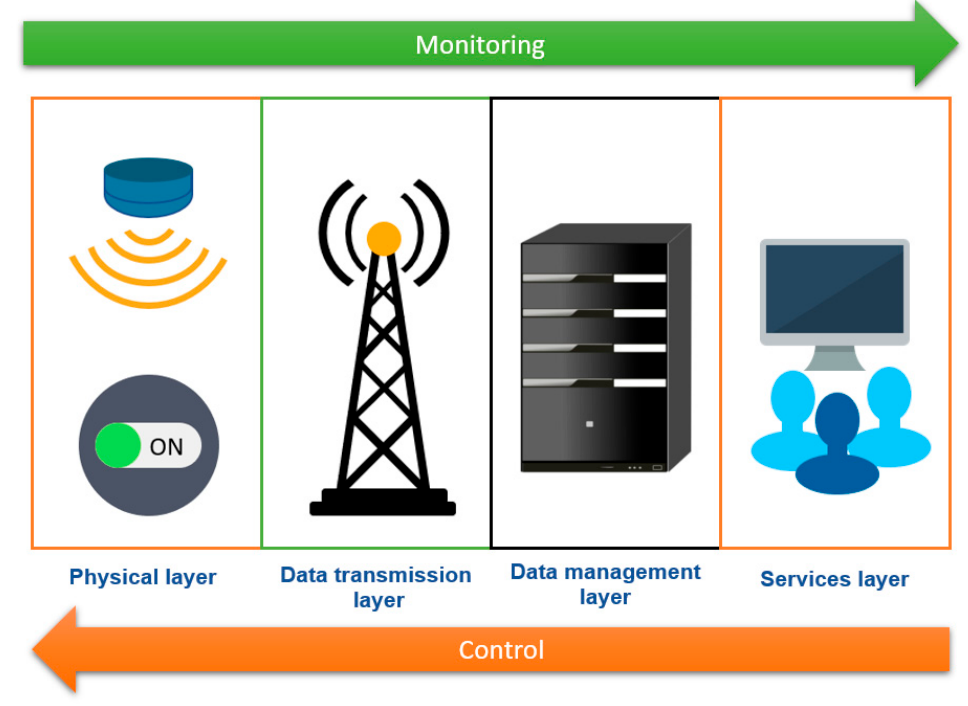
Figure 1. The architecture of the smart building system.